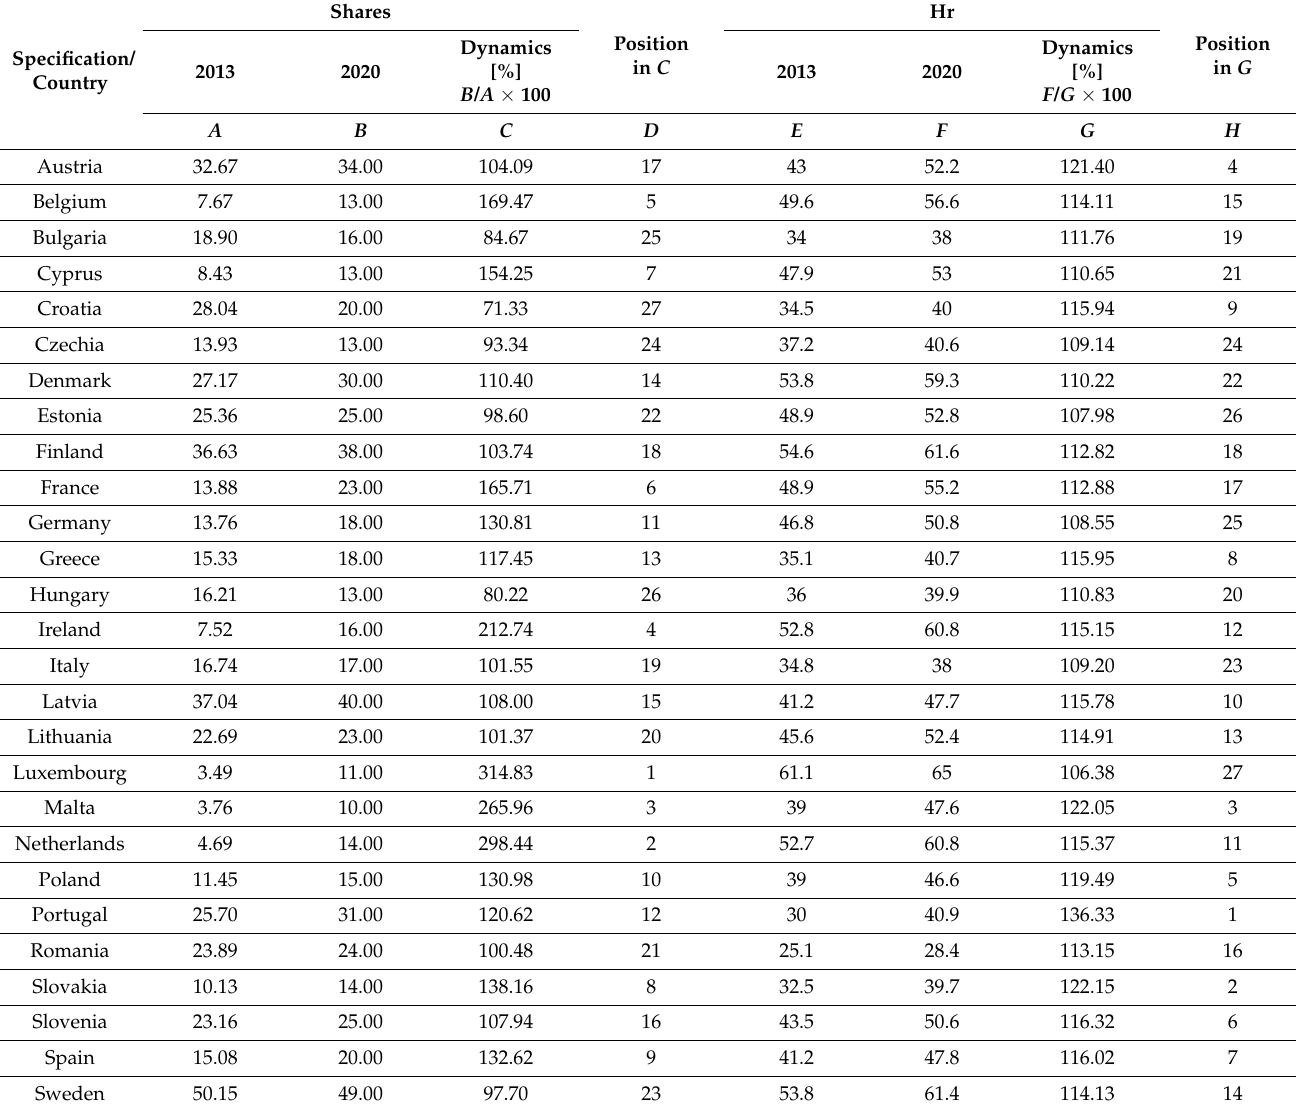
Table A2. Share of renewable energy in gross final energy consumption (in %) and share of human resources in science and technology (in %)—comparison 2013 and 2020 in EU-27 countries.